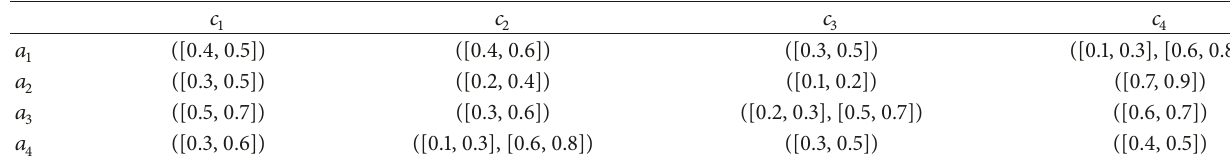
Table 3: The interval-valued hesitant fuzzy matrix 𝐴 3